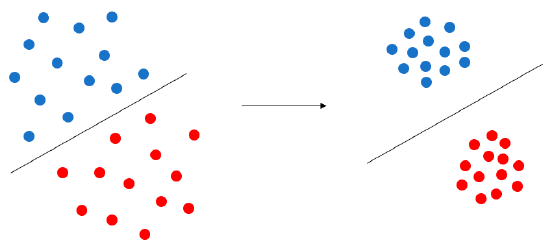
Figure 9. Purpose of Center Loss. Center Loss aggregates the feature of each category to their respective central points, which makes the similar feature more aggregated, and the different types of features spread out, making the classification clearer.